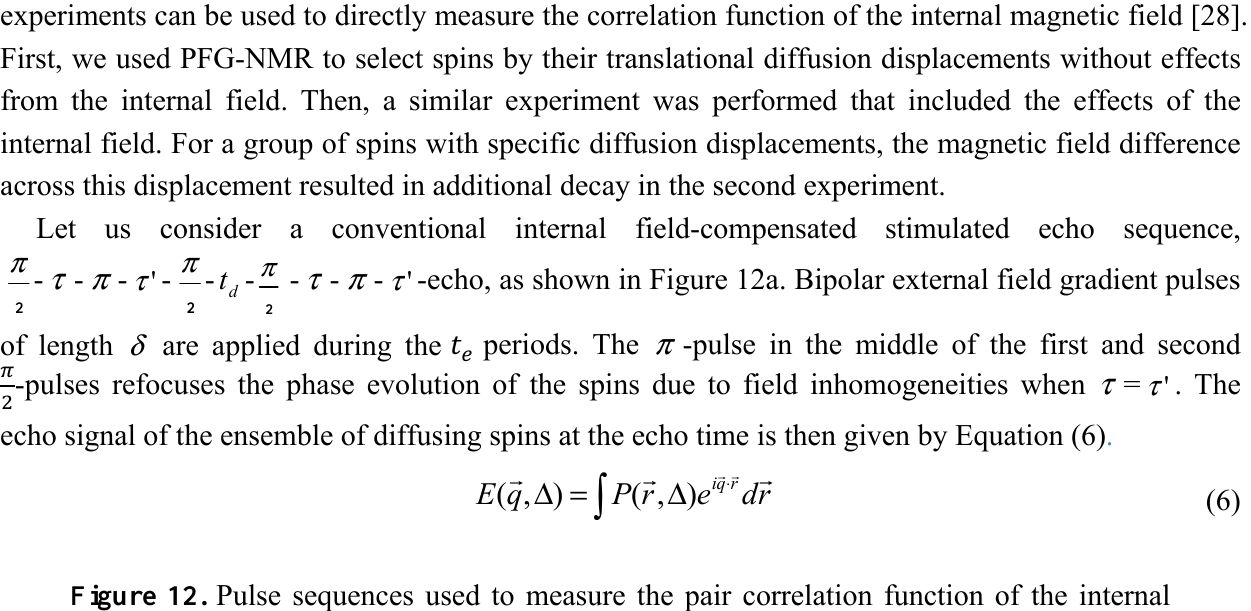
Figure 12. Pulse sequences used to measure the pair correlation function of the internal magnetic field. ( a ) Balanced sequences used to nullify the effect of the internal field; ( b ) Imbalanced sequence used to introduce the effect of the internal field. Reproduced from Reference [28] with